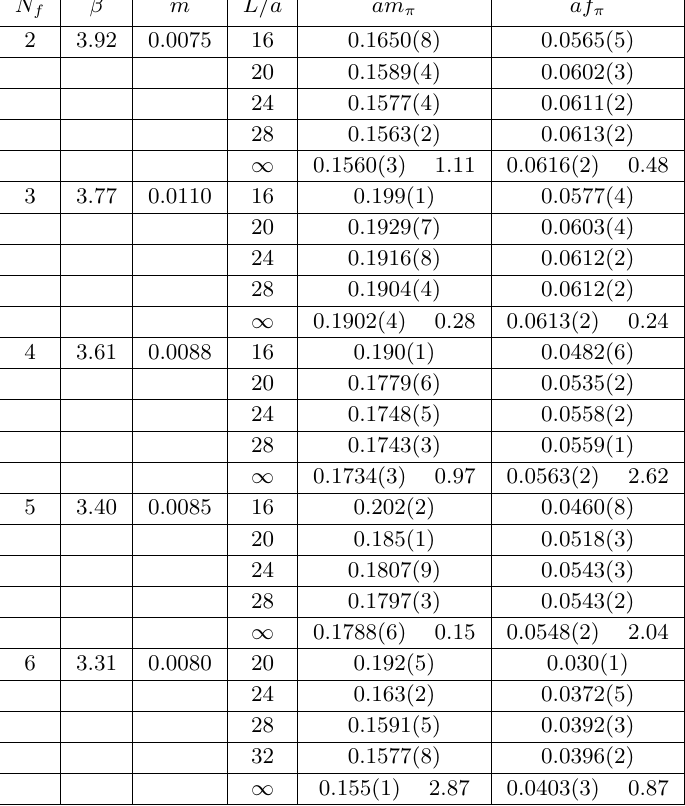
Table 2 . Volume dependence of m (cid:25) and f (cid:25) . The in(cid:12)nite volume extrapolated result is also shown together with the (cid:31) 2 =dof of the extrapolations; dof =